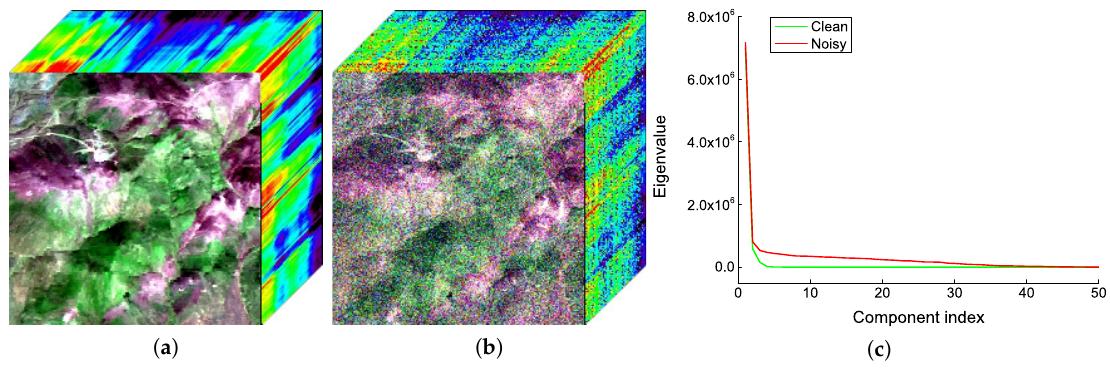
Figure 1. ( a ) Clean HSI data cube; ( b ) Noisy HSI data cube; ( c ) Eigenvalues of the sample correlation matrices computed from the clean and noisy observations shown in ( a , b ),